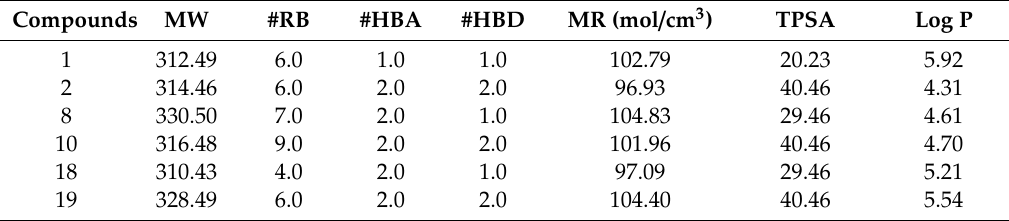
Table 4. Drug-likeness properties calculated for the most active cannabinoids.